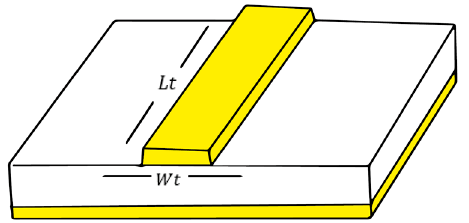
Figure 3. Transmission line of microstrip antenna.